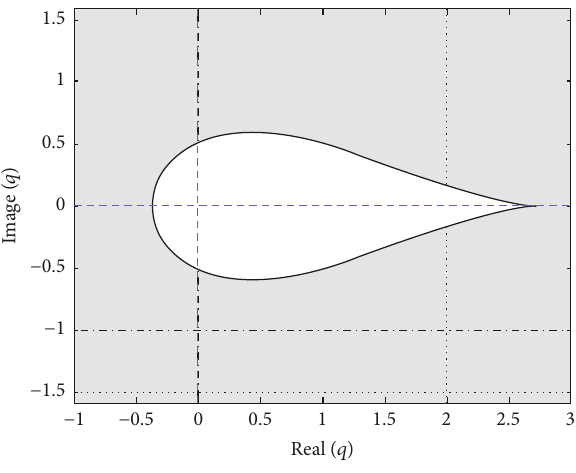
Figure 1: Region of absolute